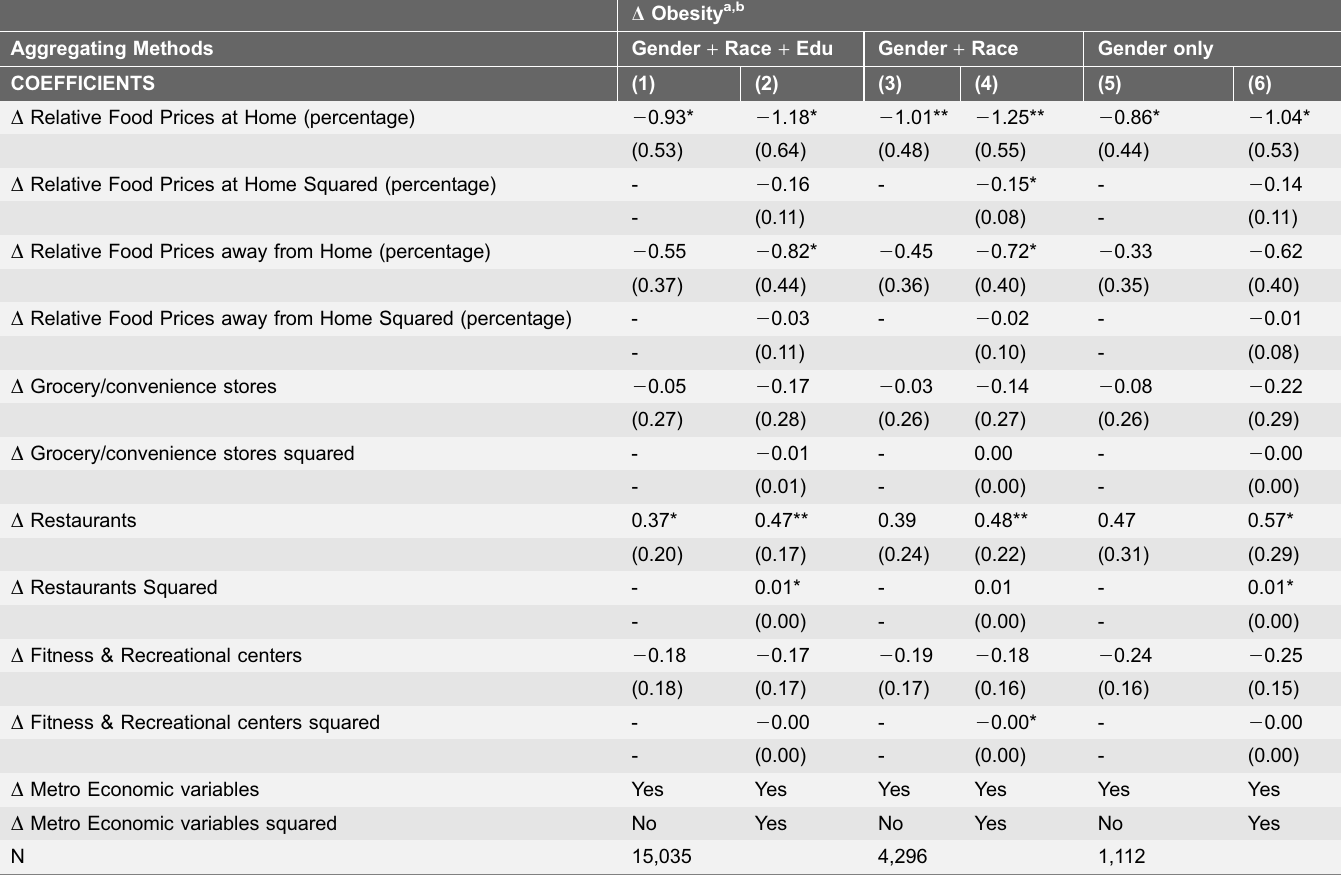
Table 8. The Estimated Effects of Relative Food Price Changes on Changes in Obesity: By Grouping